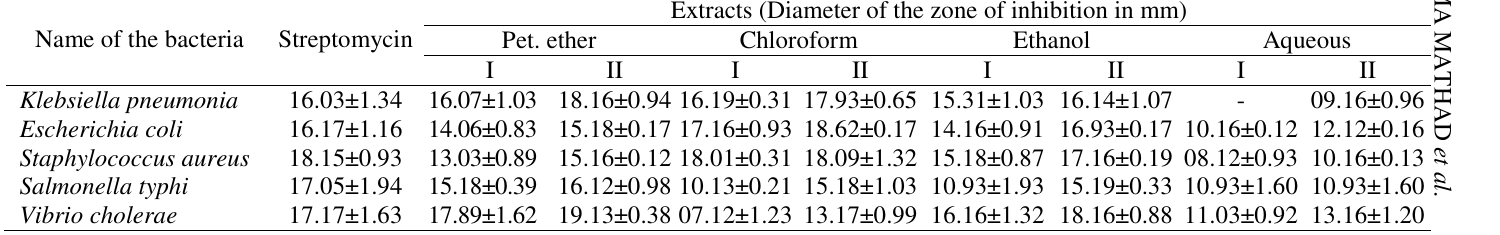
Table 3. Antibacterial activity of Digera muricata (L.) Mart. extracts on bacteria